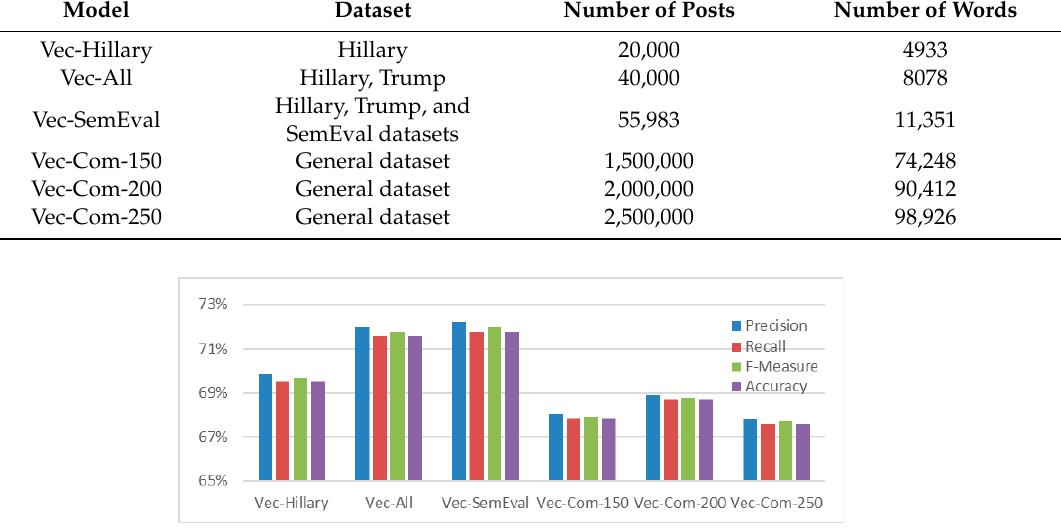
Table 1. Datasets for training word embedding models for sentiment classification.